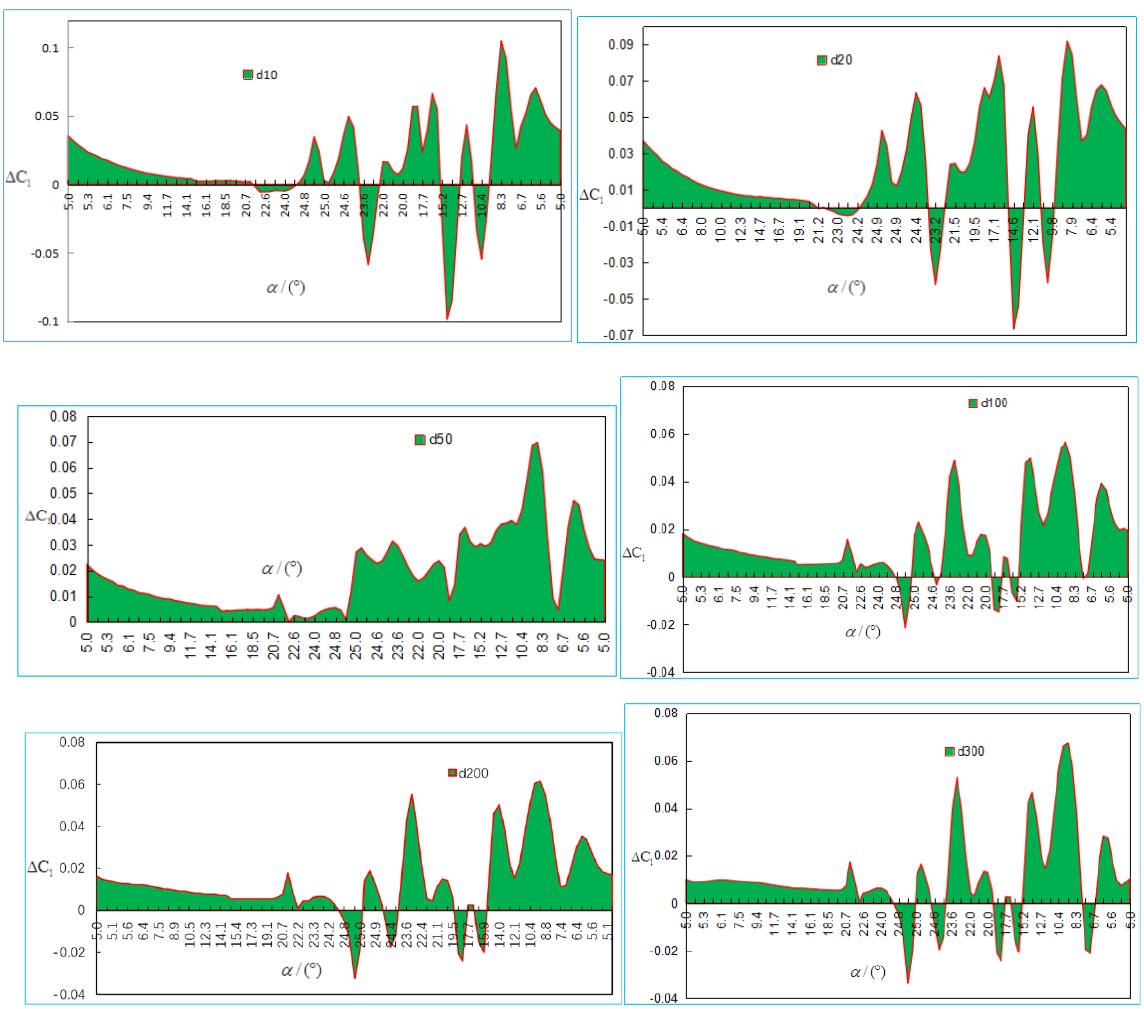
Figure 5. Effect rate of different diameter particles on the aerodynamic performance of the airfoil.